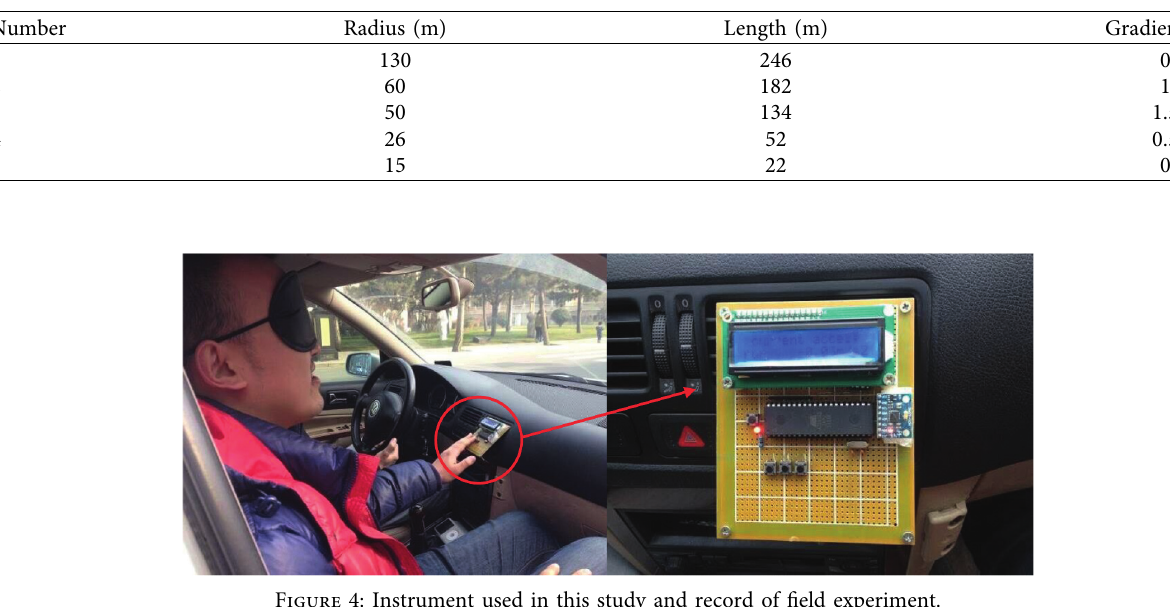
Figure 3: Field tests positions in Nanhu Park, Xi’an, China. Table 1: Radius and related information of horizontal